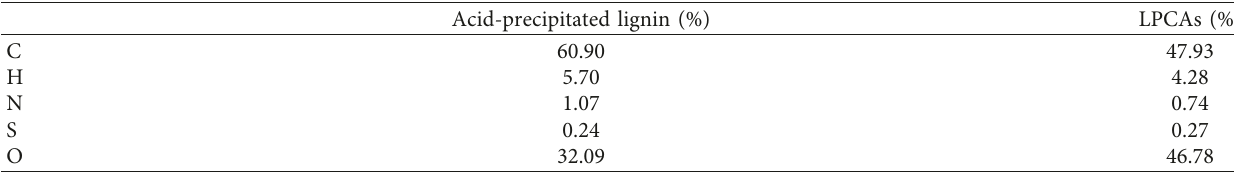
Table 2: The analysis result of the content of 5 elements of lignin.